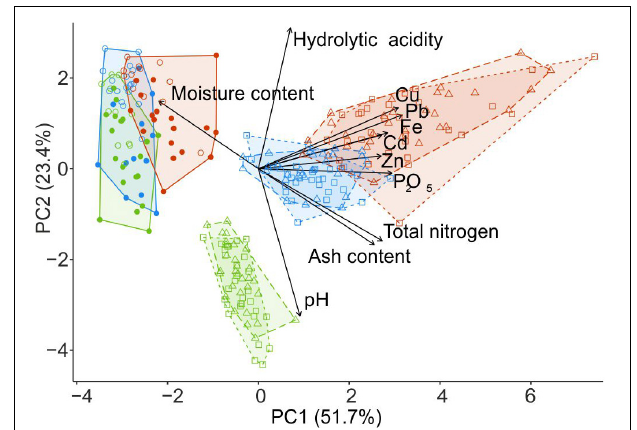
FIGURE 2 | PCA ordination of wood samples collected from fir CWD (filled circles) and spruce CWD (empty circles) and forest litter samples collected close to CWD (triangles) and far from CWD (squares) in the areas with different levels of industrial pollution (green, UP area; blue, MP; red, HP). Arrows denote the relative contribution of each variable to principal components. The percentage on each axis describes the amount of variance explained by principal components. PCA, principal component analysis; CWD, coarse woody debris; UP, unpolluted; MP, moderately polluted; HP, heavily